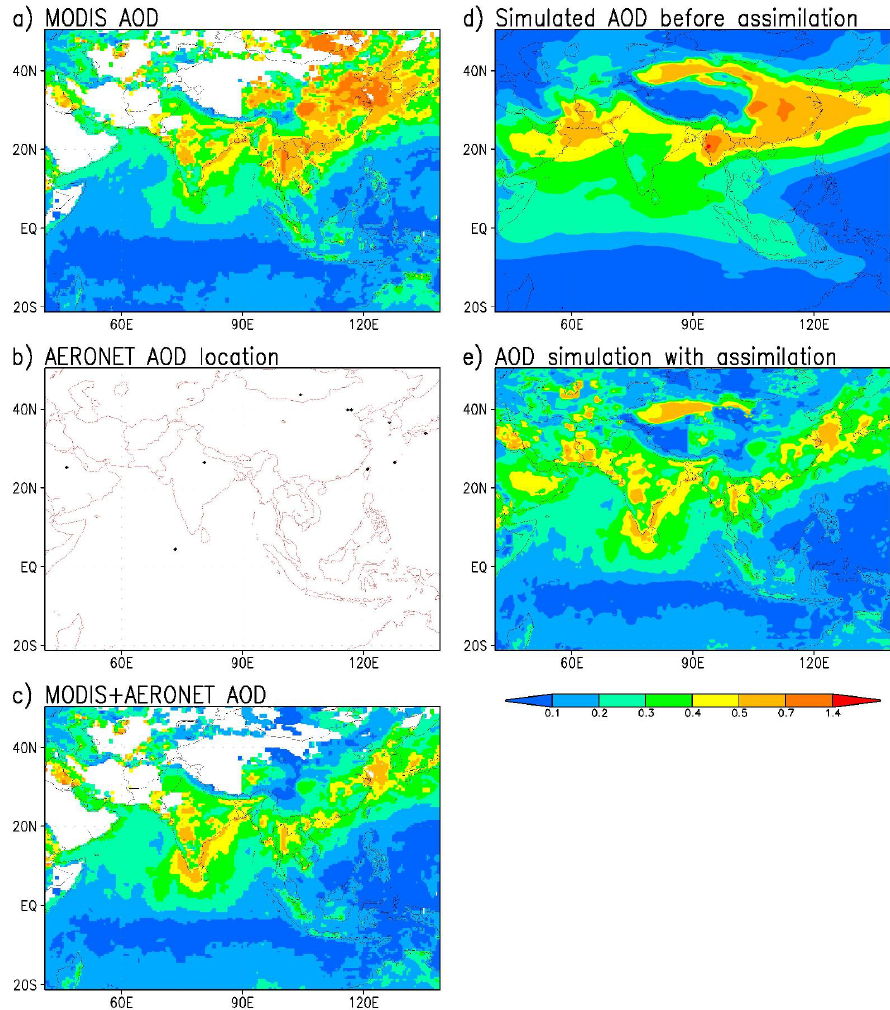
Fig. 2. Total (natural + anthropogenic) AOD (Aerosol Optical Depth). (a) Monthly AOD observation in March, 2001, from the satel- Figure 2. Total (natural + anthropogenic) AOD (Aerosol Optical Depth). A) Monthly AOD lite MODIS instrument. (b) Locations for monthly AERONET AOD data in March 2001. (c) March 2001 AOD adjusted with scattered ground observations AERONET. (d) Simulated AODs by the STEM-2K1 model (March, 2001). (e) AOD simulation after assimilating observation in March, 2001, from the satellite MODIS instrument. B) Locations for monthly MODIS+AERONET